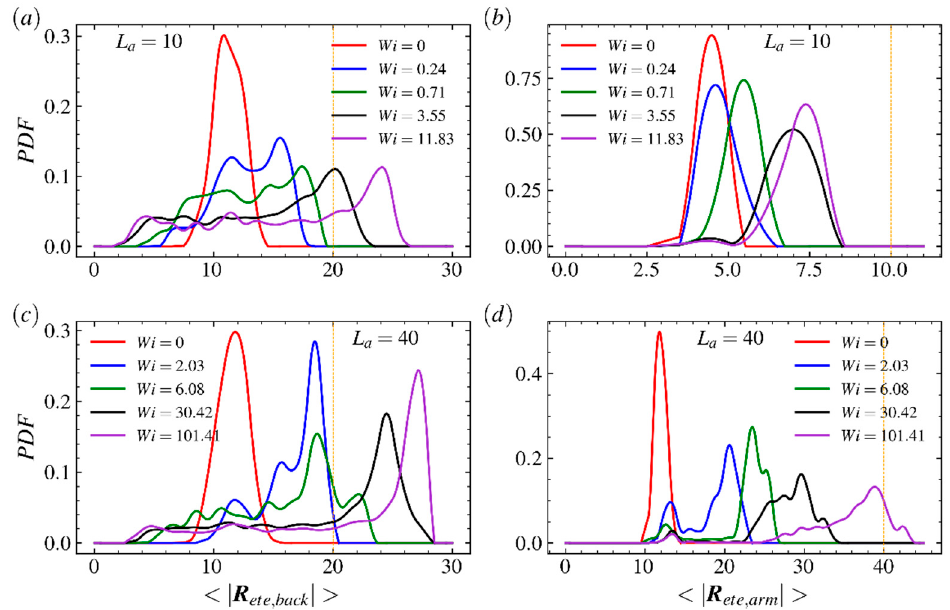
Figure 5. Probability distribution functions (PDFs) of the end-to-end distance of ( a , c ) the backbone and ( b , d ) arms of the LCB polymer with L b = 20 and ( a , b ) L a = 10 and ( c , d ) L a = 40 in shear flow with various Weissenberg numbers. The orange vertical lines are used to mark ( a , c ) backbone’s and ( b , d ) arm’s contour length.